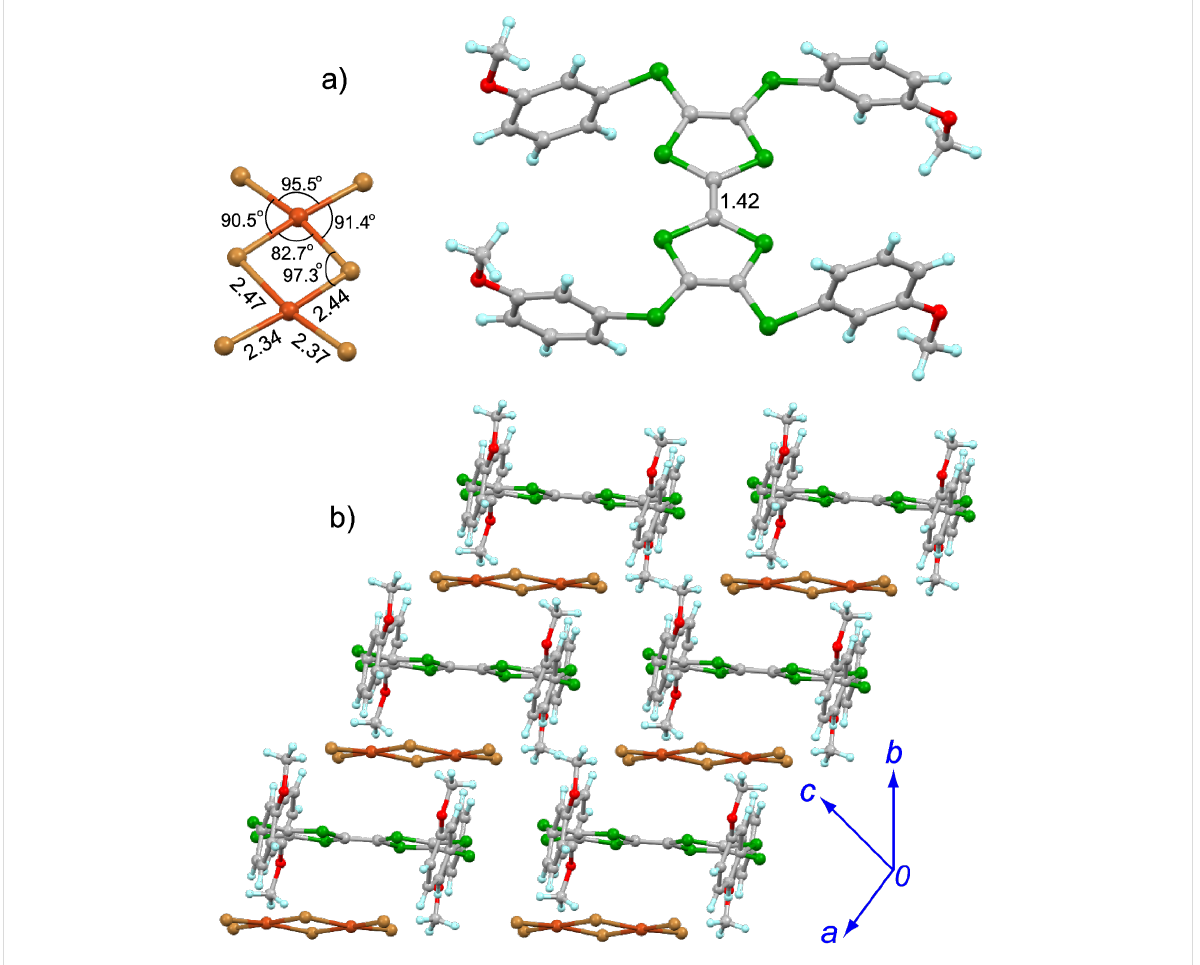
Figure 4: Crystal structure of 5 ·Cu 2 Br 6 : a) unit cell contents with the numeric data indicate the angles and bond lengths (Å); b) packing